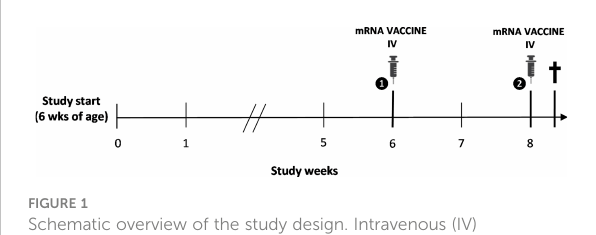
FIGURE 1 Schematic overview of the study design. Intravenous (IV) immunization with the BNT162b2 mRNA COVID-19 vaccine was performed following a two-dose regimen at 12 and 14 weeks of age, with spontaneous death of the animal two days following booster